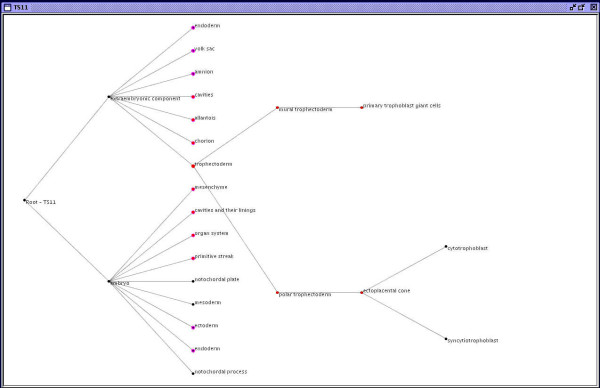
Semantic and geometric zoom in the main window. A sub-tree of interest is expanded to take advantage of maximum screen space while suppressing surrounding data of less interest, providing both a semantic and a geometric zoom.